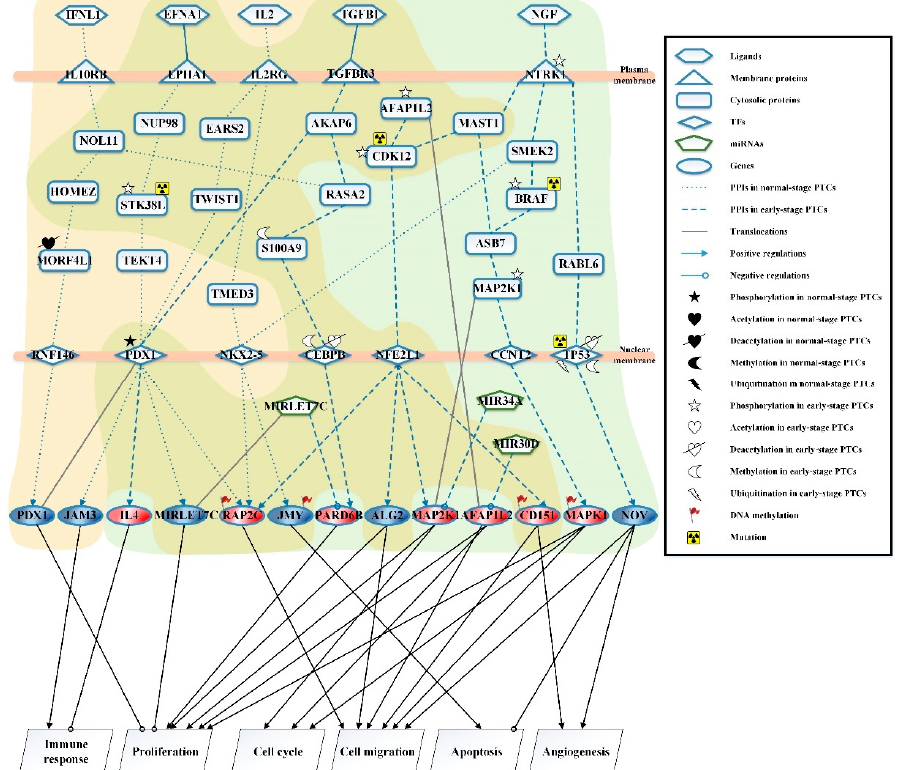
Figure 1. The core signaling pathways are obtained by projecting core GENs to KEGG pathways to investigate the carcinogenic progression mechanism from normal thyroid cells to early-stage papillary thyroid cancer cells. The blue dotted lines represent the signaling pathways in normal stage of thyroid cells; the blue dashed lines indicate the signaling pathways in early-stage of PTC; the blue solid lines denote the signal pathways in both stages; the gray solid lines represent translocation; the blue arrow head of lines represents upregulation; the blue circle head of lines represents downregulation; the black arrow head of solid lines represents activating cellular function; the black circle head of solid lines represents inhibiting cellular function; the red gene nodes indicate a higher gene expression in early-stage PTC cells compared with normal thyroid cells; the blue gene nodes indicate a lower gene expression in early-stage PTC cells compared with normal thyroid cells; the orange background covers the cellular molecules in normal stage of thyroid cells; the green background covers the cellular molecules in early-stage of thyroid cancer cells.